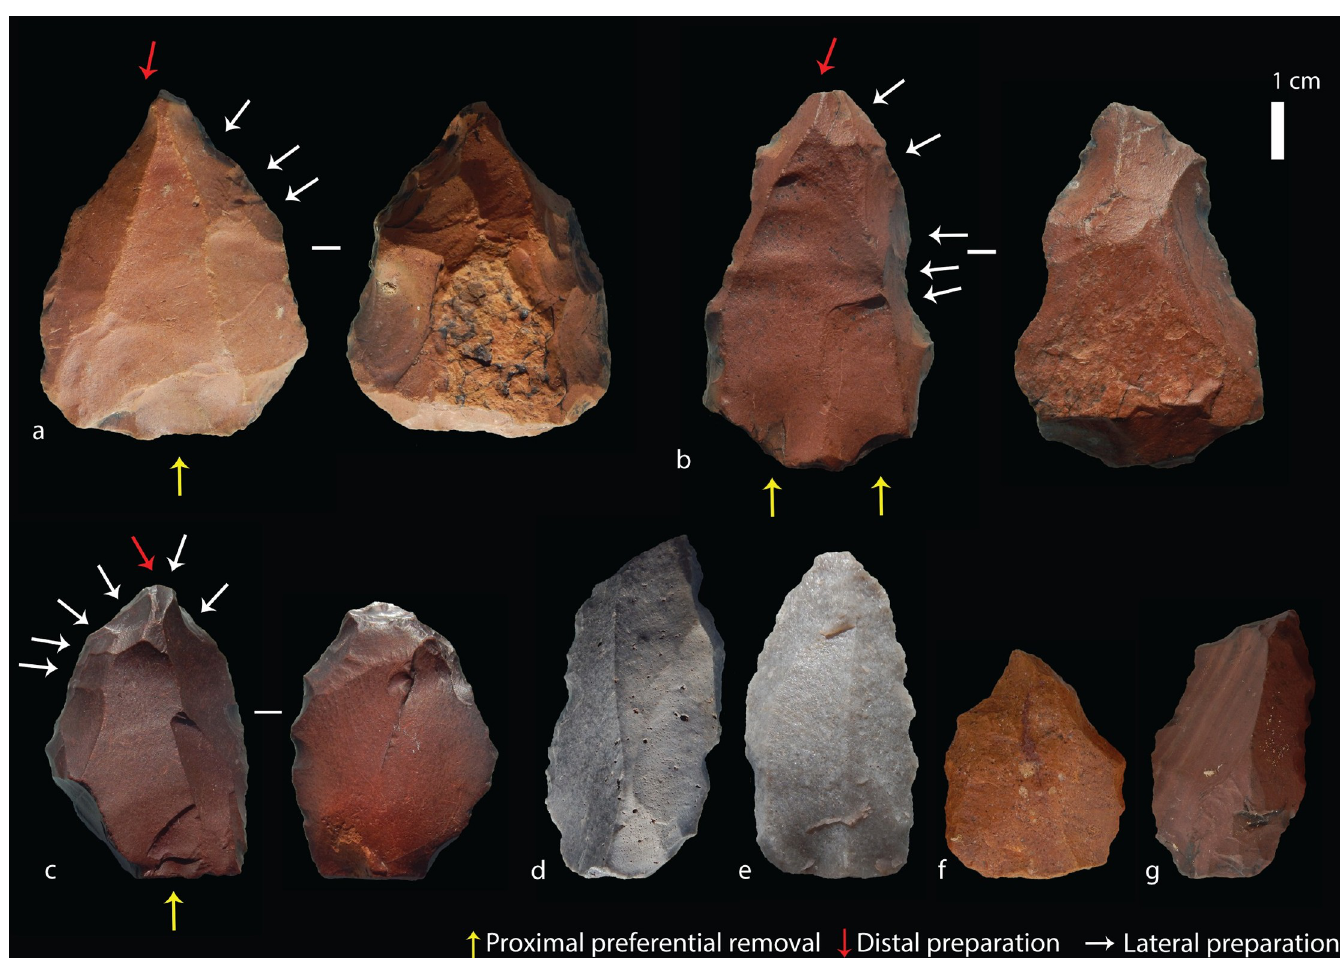
Fig 16. TWEE7 artefacts. (a-c) Nubian Type 1/2 cores, (d-g) points with informal retouch or edge-damage. Raw material: (a-b, g) hornfels, (c-d) CCS, (e) Dwyka quartzite, (f) silcrete.